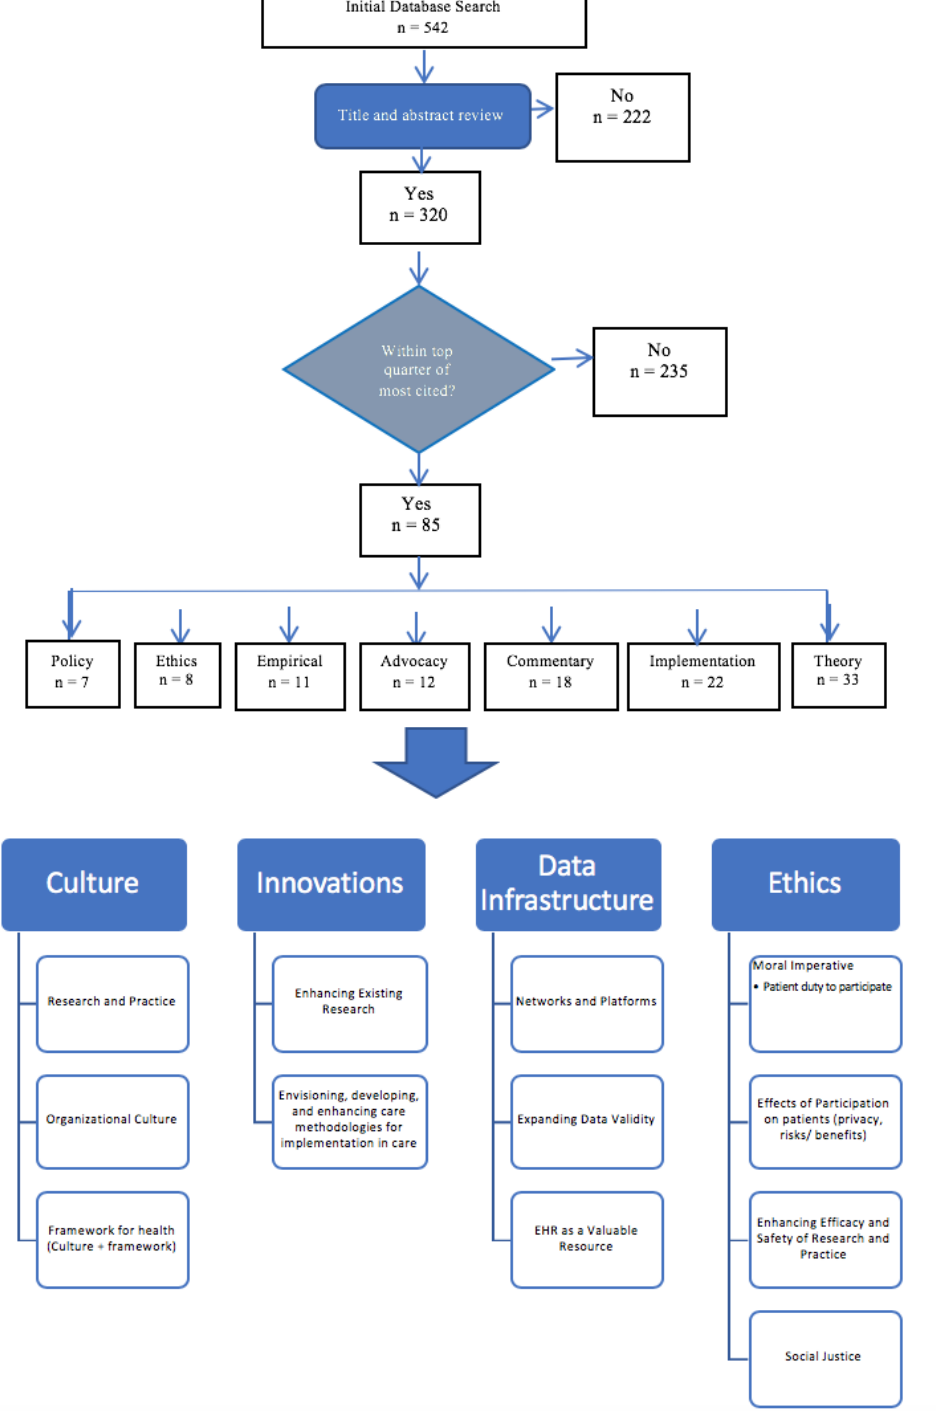
Figure 2. Summary of search strategy and